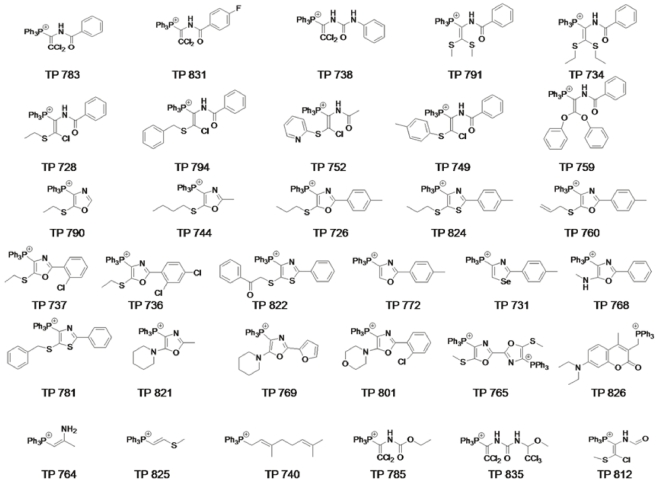
Structural analogues of TP 187, TP 197 and TP 421.